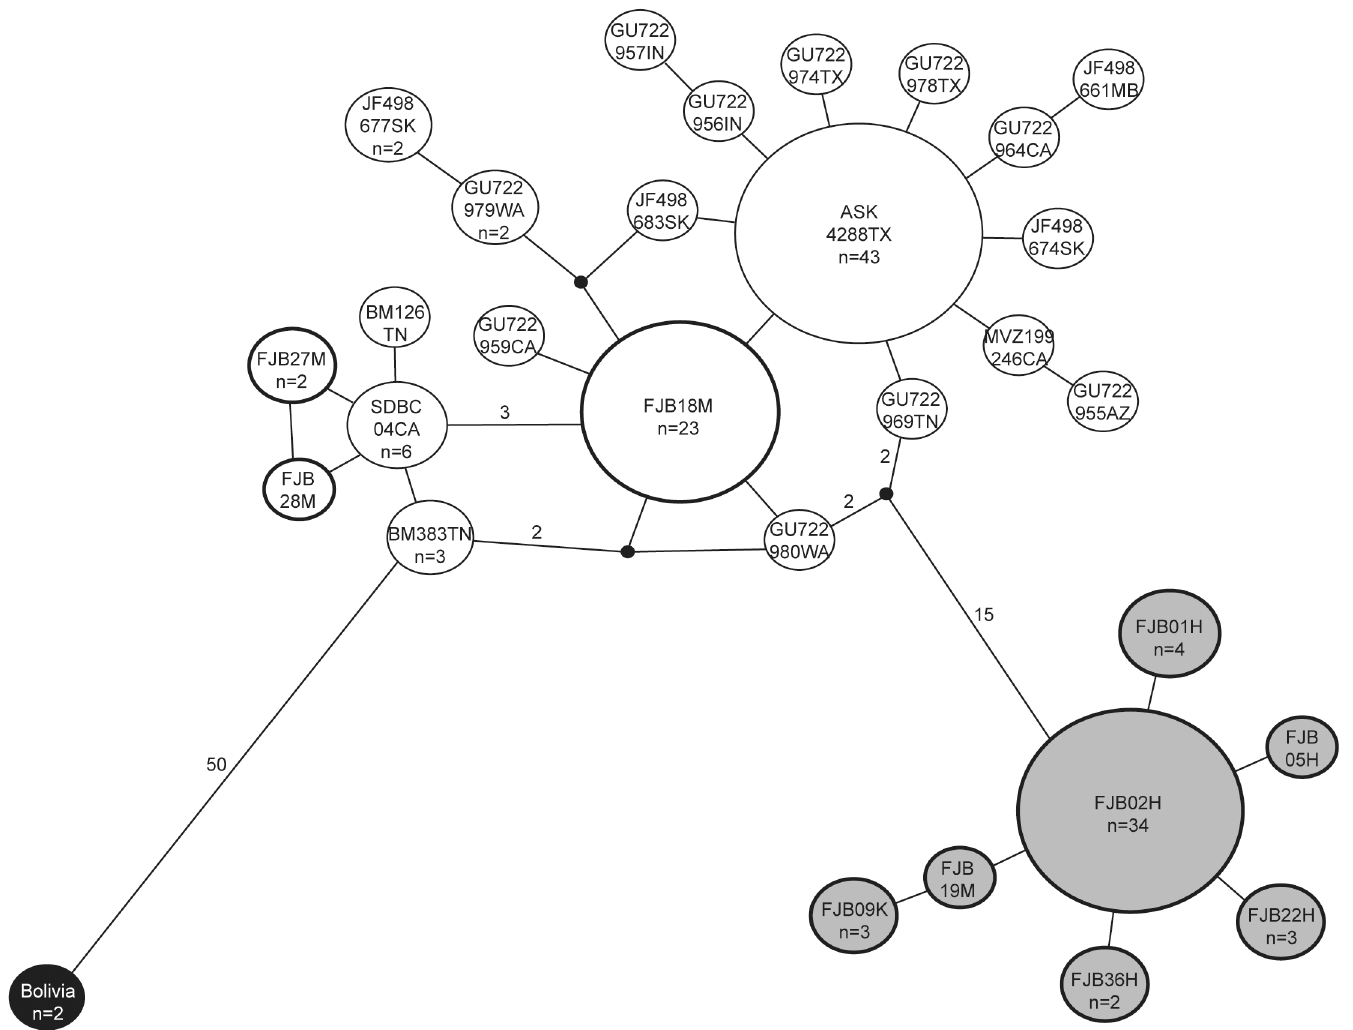
Fig 2. Maximum parsimony network of CO1 haplotypes. Each haplotype is represented by a circle, the relative size of which roughly corresponds to the haplotype frequency. The number of mutations between haplotypes is indicated only for those connections spanning more than one mutation. Hawaii1 haplotypes grey, Hawaii2/North America haplotypes white, South American haplotype black. Hawaiian islands haplotypes in bold.